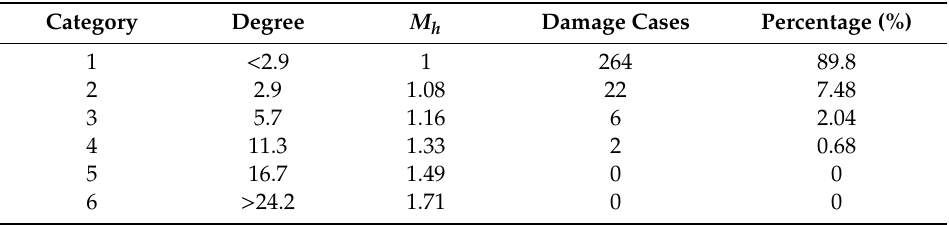
Table 6. Damage cases based on the slope conditions.